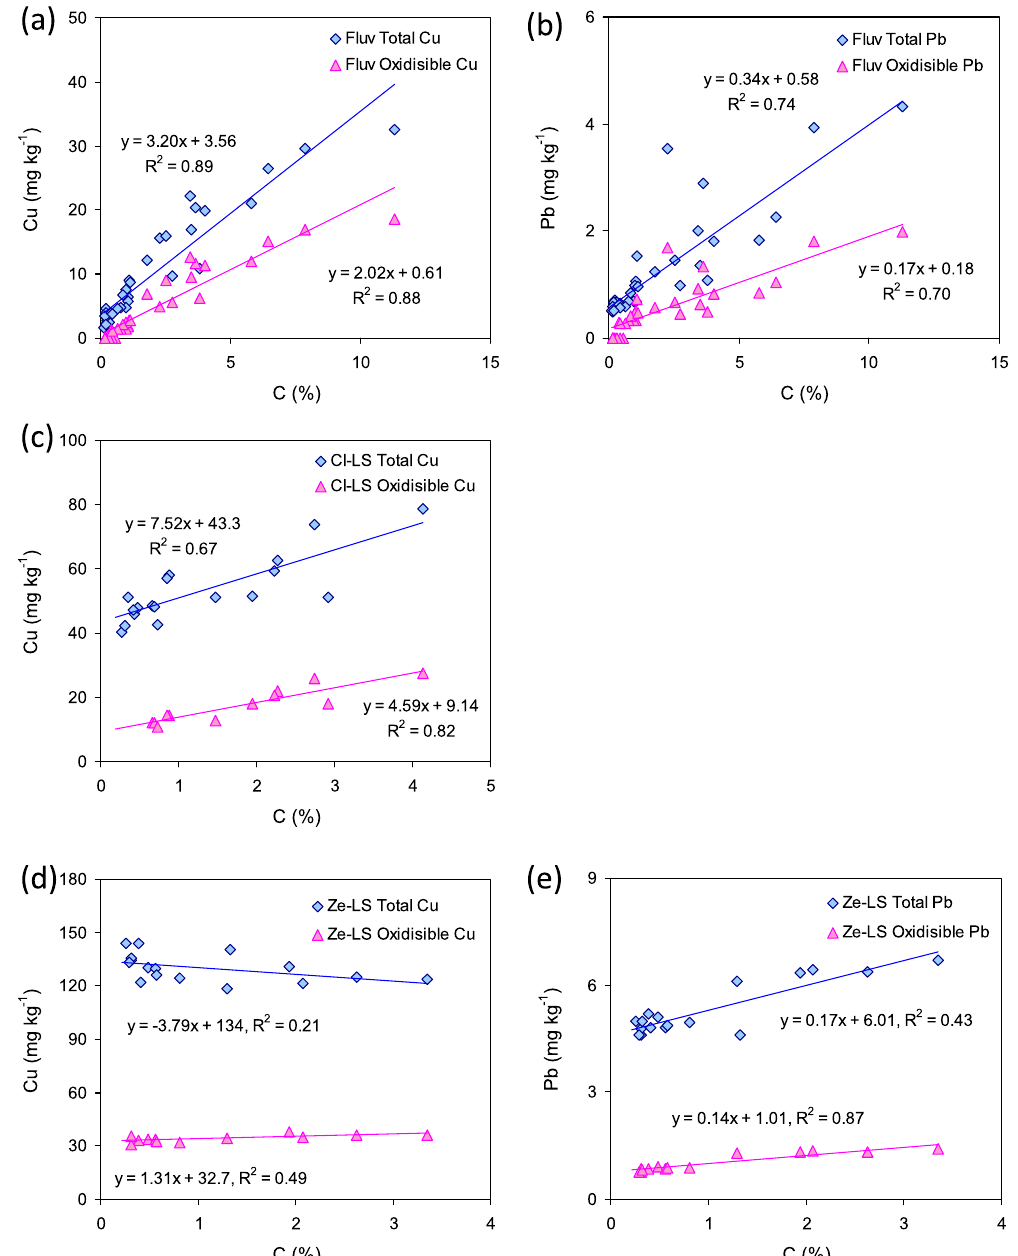
Figure 5. Correlations between carbon contents and total and oxidisible Cu and Pb in the filter materials of constructed wetlands based on ( a , b ) fluviatile sand (Fluv), ( c ) clinopyroxene- (Cl-LS) and ( d , e ) zeolite- dominated lava sand